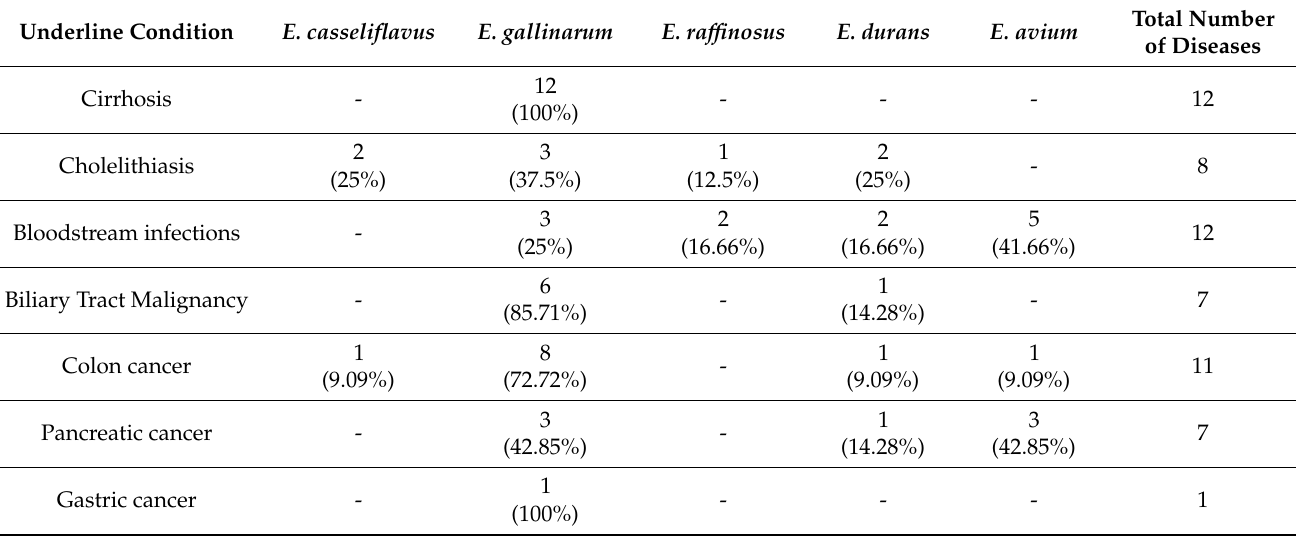
Table 4. Several underlying conditions associated with other Enteroccocus infections.